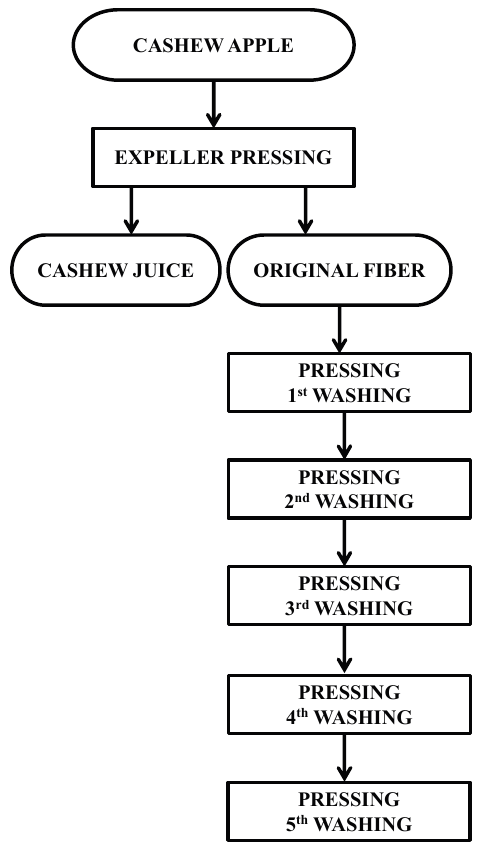
Figure 3. Flowchart of cashew fiber obtainment and